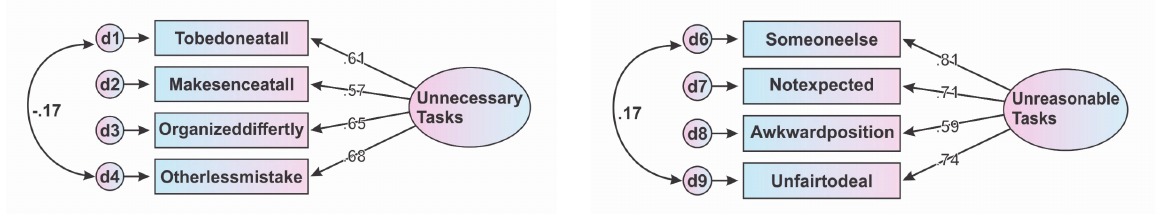
Fig. 2. Measurement model of unnecessary tasks Fig. 3. Measurement model of unreasonable tasks